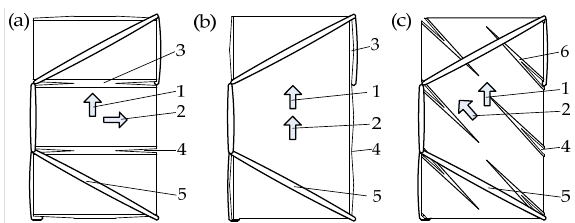
Figure 3. Meso ‐ scale geometrical model of unidirectional (UD) specimens with different angle between fiber direction and process direction: ( a ) 90°; ( b ) 0°; and ( c ) 45°. 1—Process direction; 2— Fiber direction; 3—Face channel; 4—Inner crack; 5—Stitching yarn; 6—Face crack.